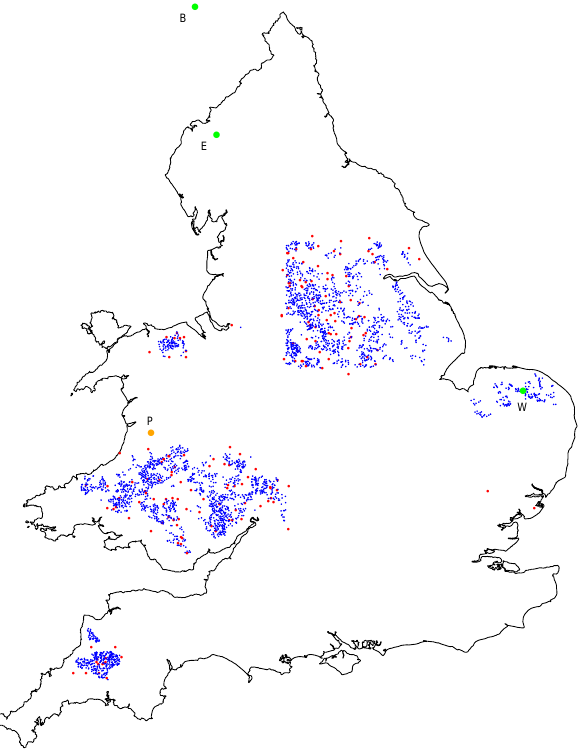
Fig. 1. Locations of sites referred to in this study across England and Wales (coastline shown). Blue symbols show the headwater stream survey sampling locations. Red discs show the nearest national river flow archive gauging stations to the survey sites. Green symbols are headwater sites from which temporal (weekly or monthly) data were available for p CO 2 and stream temperature: E=Eden (Pow), W=Wensum, B=Black burn in Scotland. Orange disc shows the location of the Upper Hafren at Plynlimon (P) from which stream water temperature data was